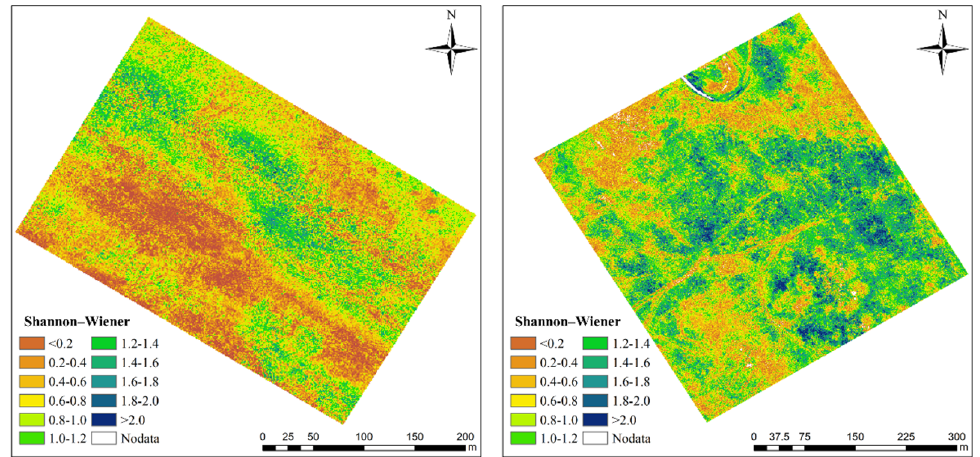
Figure 5. Predicted Shannon–Wiener index with a spatial resolution of 1 m in the natural grassland of UAV flight region 1 ( left ) and UAV flight region 2 ( right